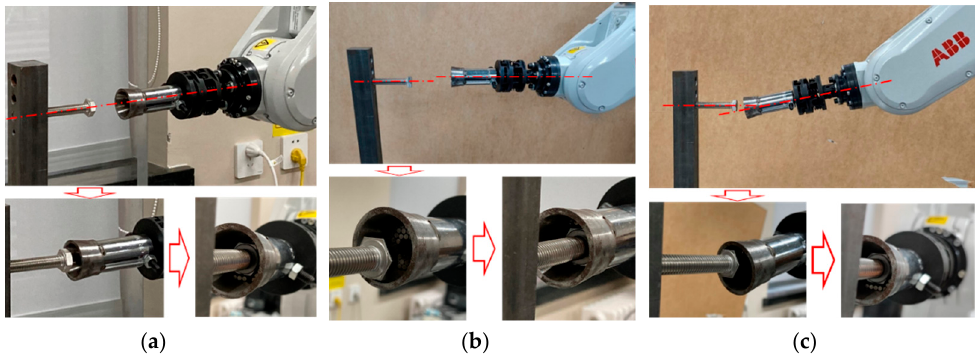
Figure 24. Docking tests. ( a ) The docking condition without deviation. ( b ) The docking condition with radial deviation. ( c ) The docking condition with angle deviation.